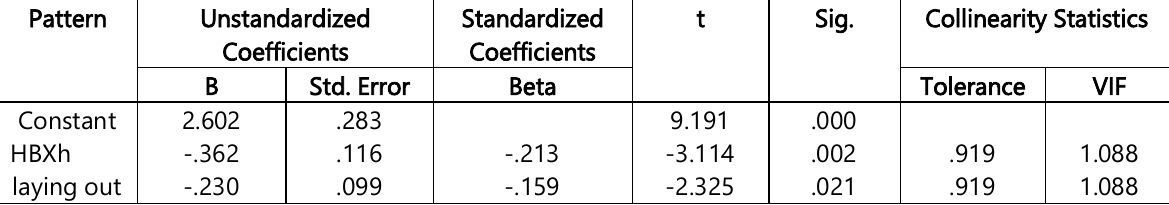
Table 11: Regression Coefficients of the Independent Variables (Source: Authors’ calculation) Pattern Unstandardized Standardized Coefficients Coefficients B Std. Error Beta Tolerance VIF Constant 2.602 .283 HBXh -.362 .116 -.213 laying out -.230 .099 -.159